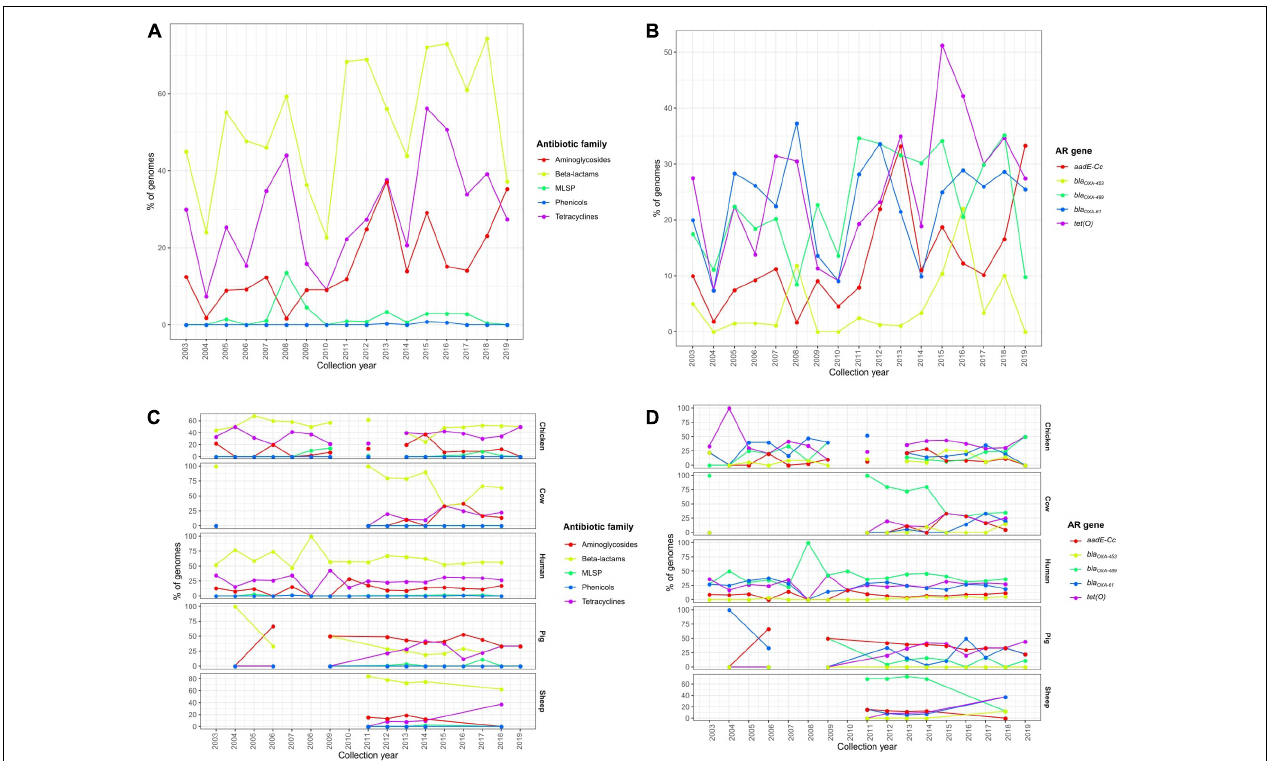
FIGURE 8 | Temporal changes in the resistome of European C. coli genomes. Prevalence of (A) ARGs or SNPs associated with resistance to different antibiotic families and (B) the main ARGs or SNPs found on all European C. coli genomes and (C) the main ARGs or SNPs and (D) AR patterns on C. jejuni genomes from chicken, cow, human, pig, and sheep sources along the last 20